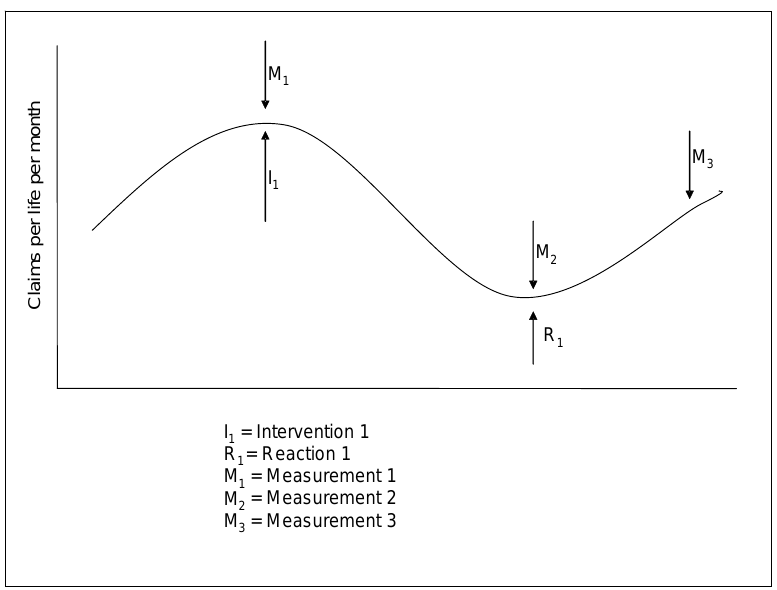
Figure 5: Claims per life per month utilisation curve of medical